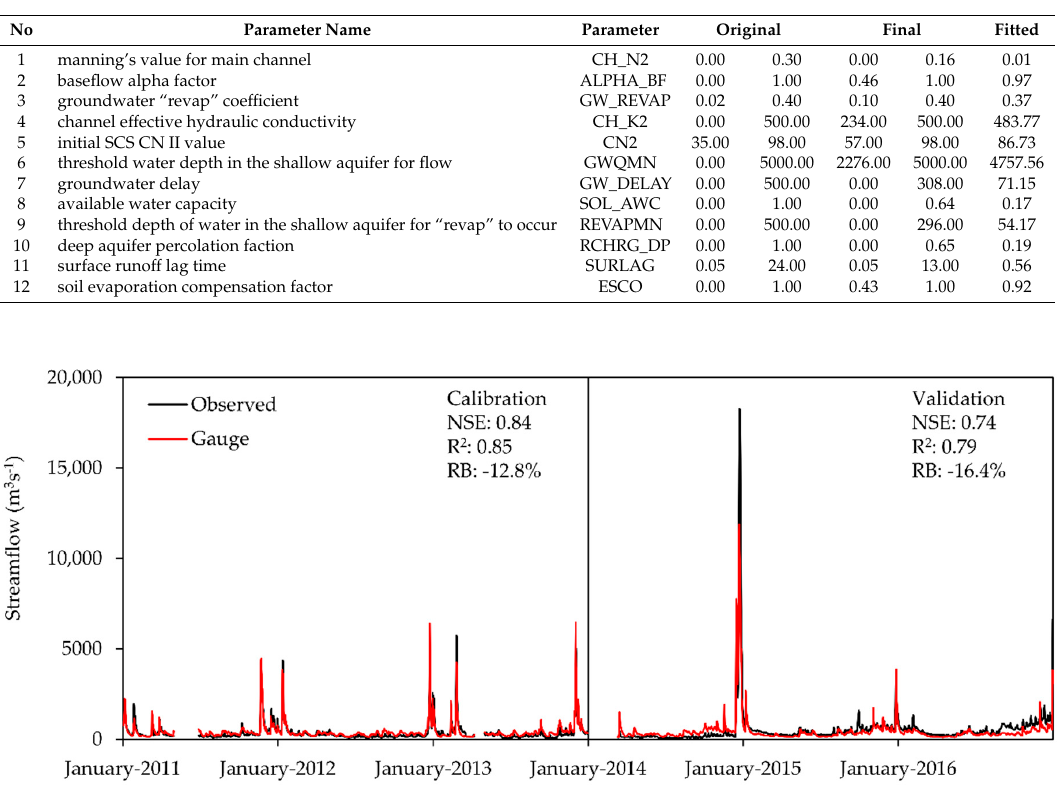
Figure 5. Hydrological reliability assessment of the GPM IMERG products in simulating daily streamflow at the Jambatan Guillermard using the SWAT model from 12 March 2014 to 31 December 2016. Figure 6 shows the temporal variability and statistical analysis of the SWAT monthly streamflow using the gauge and the three IMERG products. The results show that all the precipitation products had a better performance in the monthly streamflow simulation compared to the daily streamflow simulation. The IMERG_F is the only product that categorized a “very good” performance, with NSE, R 2 and RB values of 0.86, 0.9 and − 7.1%, respectively. In addition, the IMERG_E outperformed the IMERG_L in the monthly streamflow simulation, indicating the reprocess scheme within the IMERG_L is less beneficial in this tropical basin. Similarly, the IMERG_E and IMERG_L showed a significant underestimation of SWAT monthly streamflow by 28.3% and 36.6%, respectively. Monthly